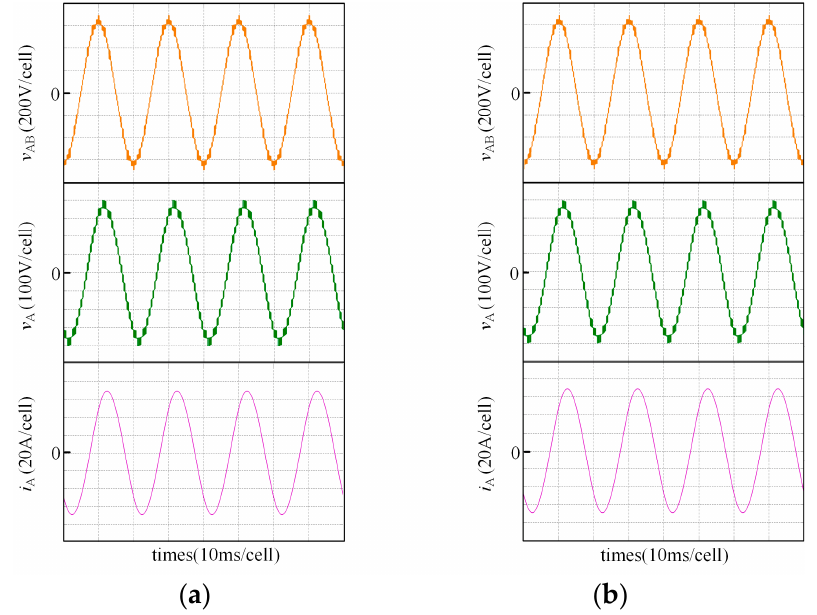
Figure 16. Experimental output waveforms of the converter at cos ϕ = 0.954 ( N = 8). ( a ) The proposed modulation method, ( b ) the conventional modulation method.